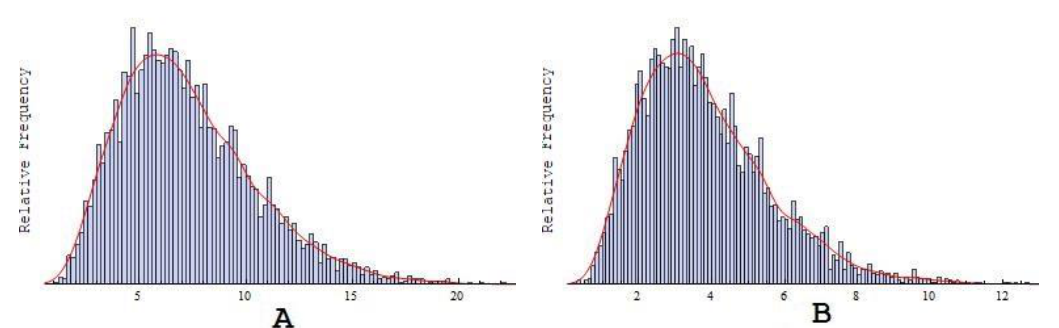
Figure 4. Histogram graph for the power capacity of the Sete Cidades case according to data from Table 2 and based on the Monte Carlo simulation. ( A ) Climeon module; ( B ) traditional binary power plants ( x -axis in MWe).